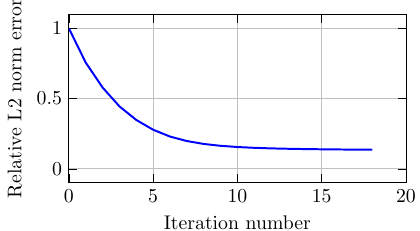
Figure 13. Computed relative L 2 norm error of projections for the experimental study as a function of number of